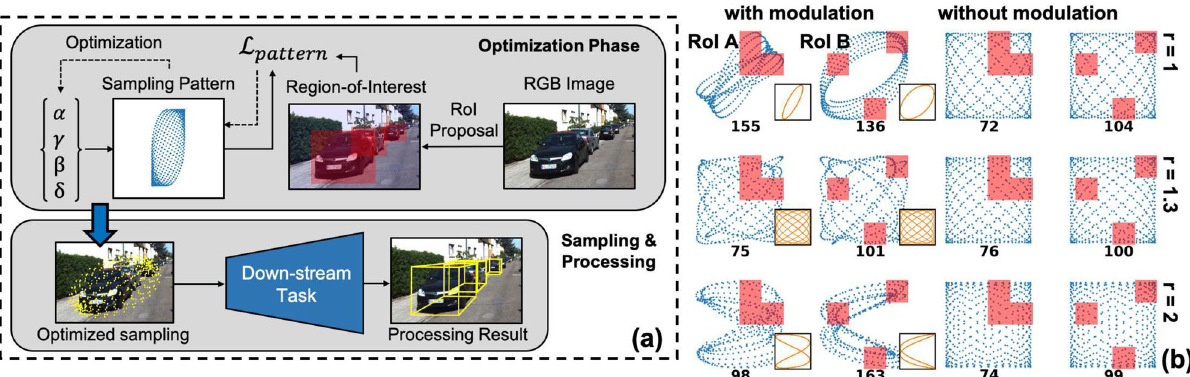
Figure 2. ( a ) Schematic pipeline of the proposed optimization framework. It shapes the sampling pattern into task-specific (or even scene-specific) RoI-focused patterns through objective function L pattern . Here 3D object detection is used as a target task. ( b ) Optimization results for different RoI and resonant frequency ratios. Red rectangles show the specified RoI and black numbers under each pattern show the amount of sampling points within the RoI. With r ∼ 1 and r ∼ 2 , the modulated scanning patterns have denser sampling in RoI,